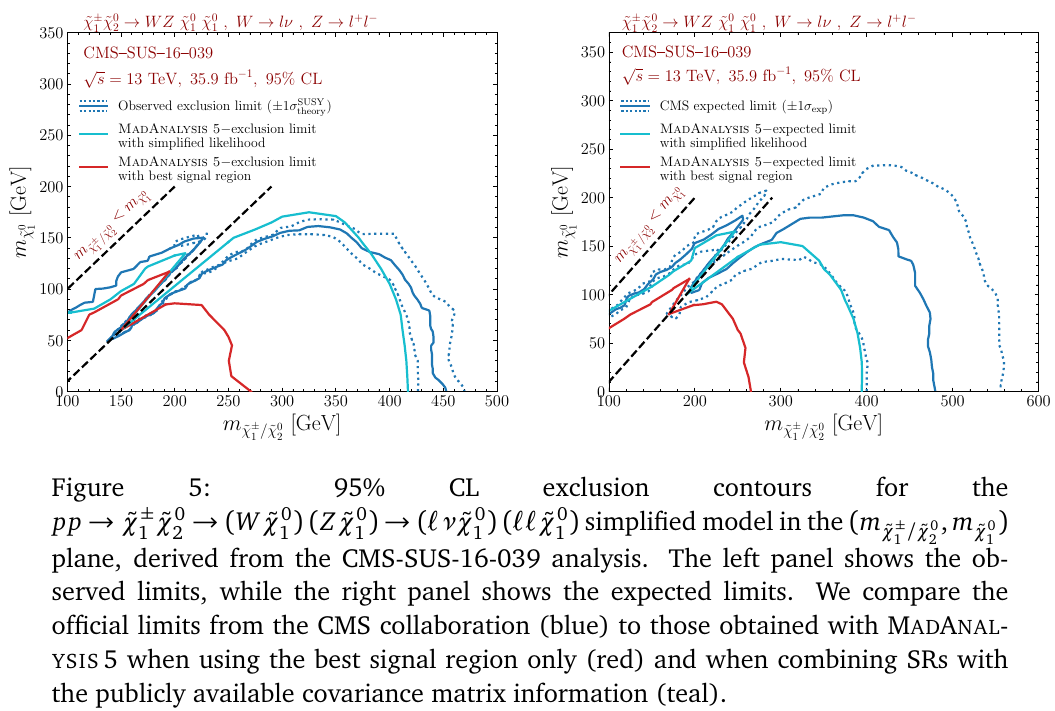
) , m / ˜ χ 0 ˜ χ 0 ˜ χ ± 1 2 1